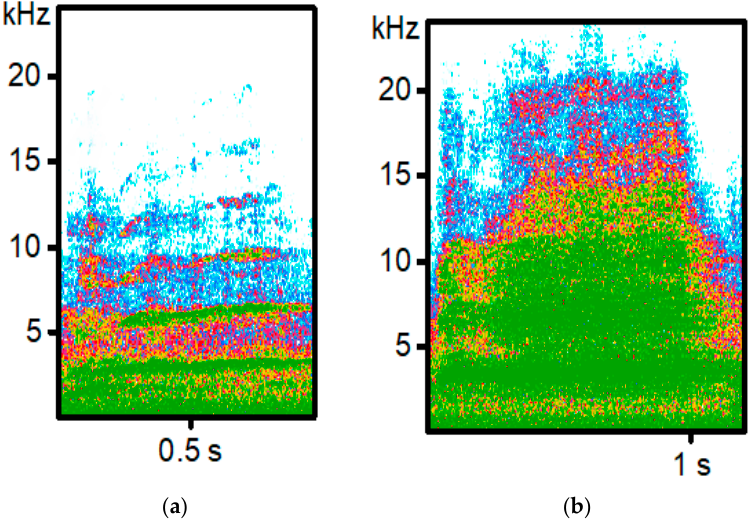
Figure 1. Representative spectrograms recorded from piglets in two different conditions. ( a ) Crushed by a sow; ( b ) Restrained by a human handler.